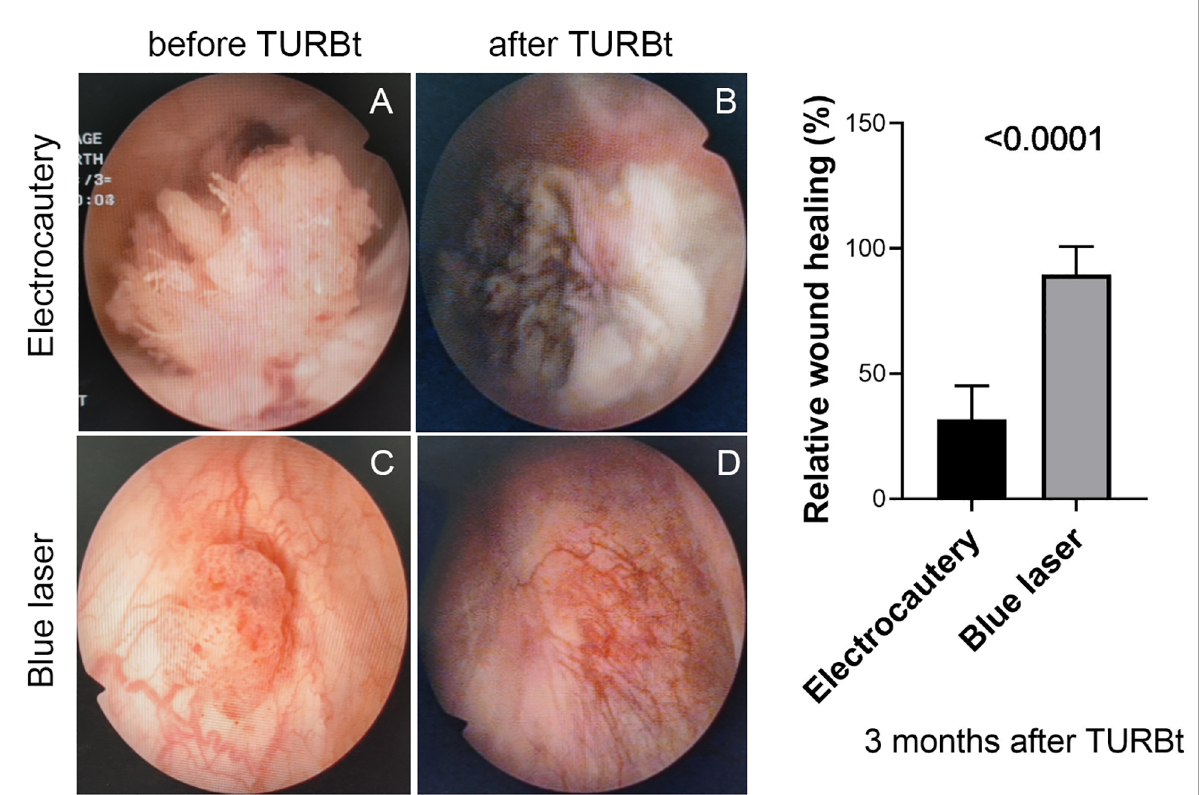
FIGURE 2 Cystoscopic examination of bladder tumours before TURBt and wound healing at 3 months after TURBt. Left panel, two representative patients in different groups treated with plasmakinetic electrocautery ( A , before TURBt; B , after TURBt) or blue laser ( C , before TURBt; D , after TURBt). Right panel, statistical analysis of wound healing rate between two groups after TURBt with plasmakinetic electrocautery or blue laser,